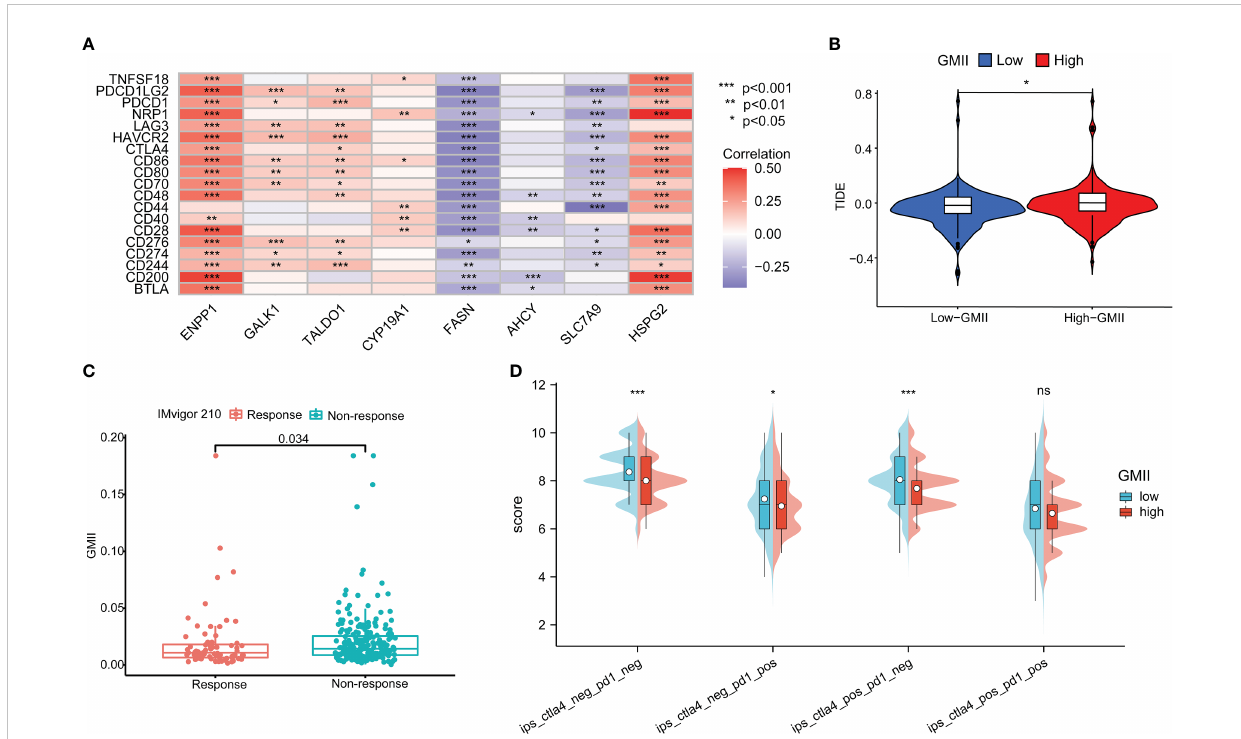
FIGURE 8 Application of GMII in immunotherapy prediction. (A) GMII gene expression was associated with common immune checkpoints. (B) TIDE scores were used to compare immunotherapy ef fi cacy between high-GMII and low-GMII groups. (C) The IMvigor 210 database analyzed GMII in the responding and non-responding groups to immunotherapy. (D) The difference in response between high-GMII and low-GMII groups to PD1- or no- CTLA4 blockers, PD1 blockers, CTLA4 blockers, and PD1-CTLA4 co-blockers. * p < 0.05 、 ** p < 0.01, *** p < 0.001. ns, Non Signi fi